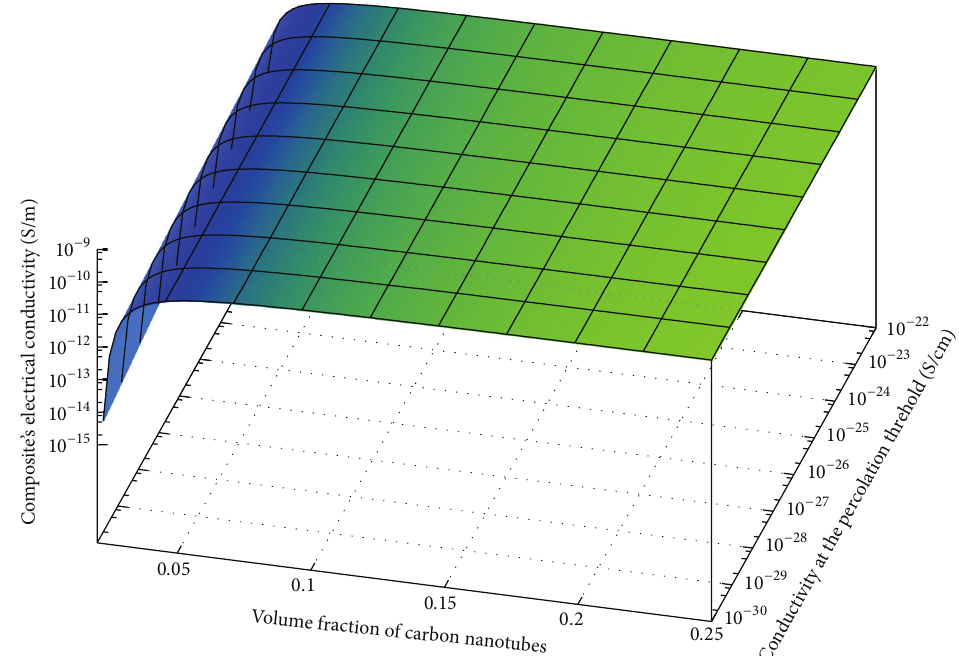
Figure 20: DC electrical conductivity of the nanocomposite when both the conductivity at the percolation threshold of the filler and the volume fraction of the filler are varied (Mamunya’s